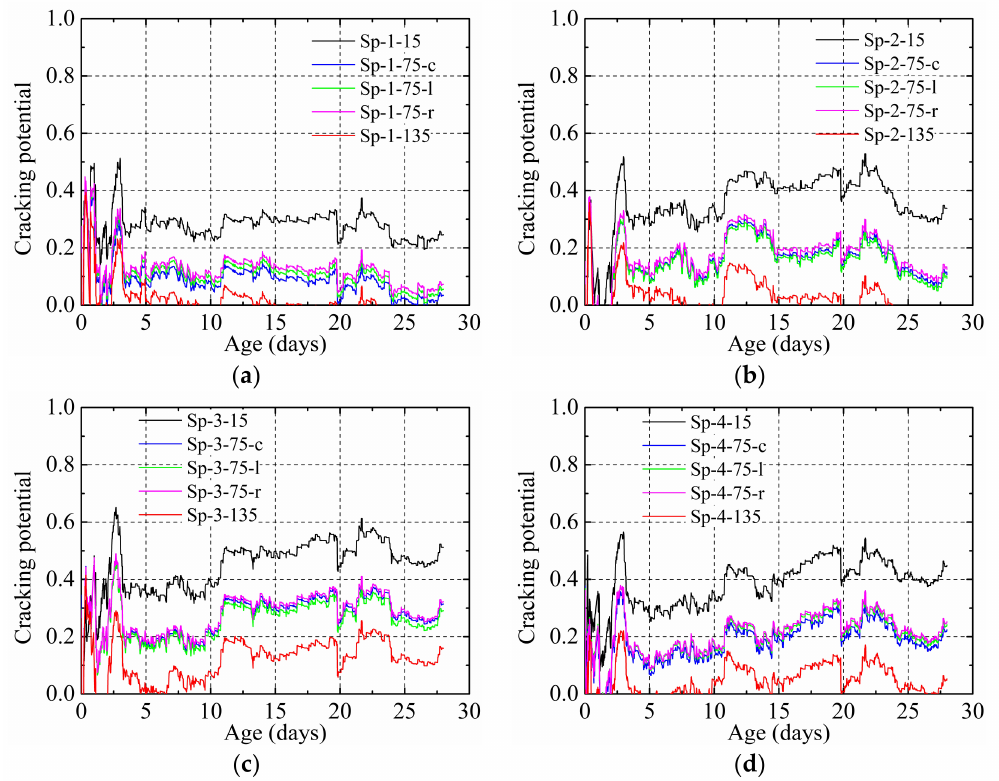
Figure 15. Cracking potential of the HPC restrained by steel plate: ( a ) Sp-1, ( b ) Sp-2, ( c ) Sp-3, and ( d )